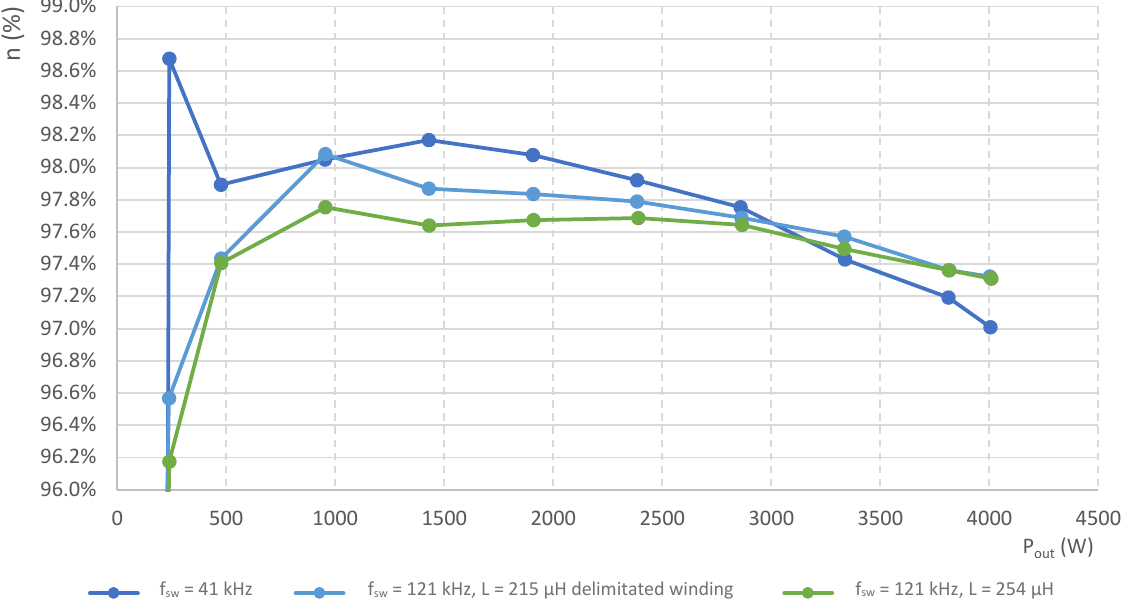
Figure 21. Comparison of the efficiency performance in dependency on the output power of converter for original and optimized cases of power inductors.